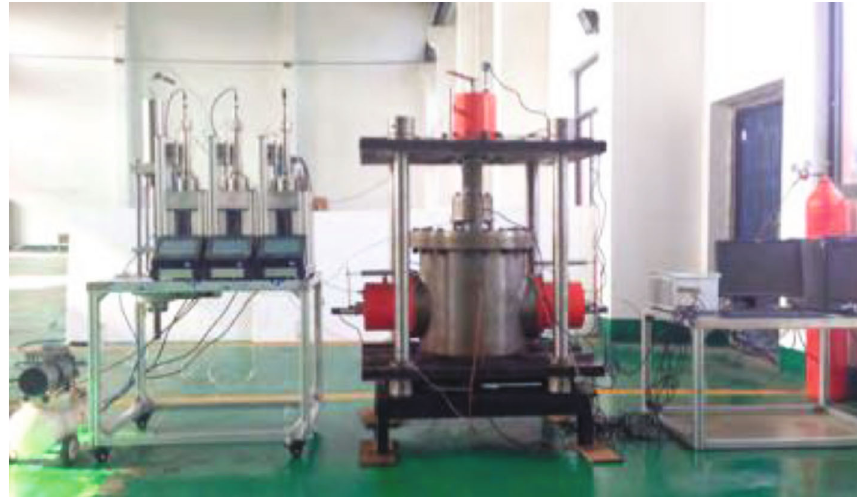
Figure 5: Diagram of gas-solid coupling experiment device.